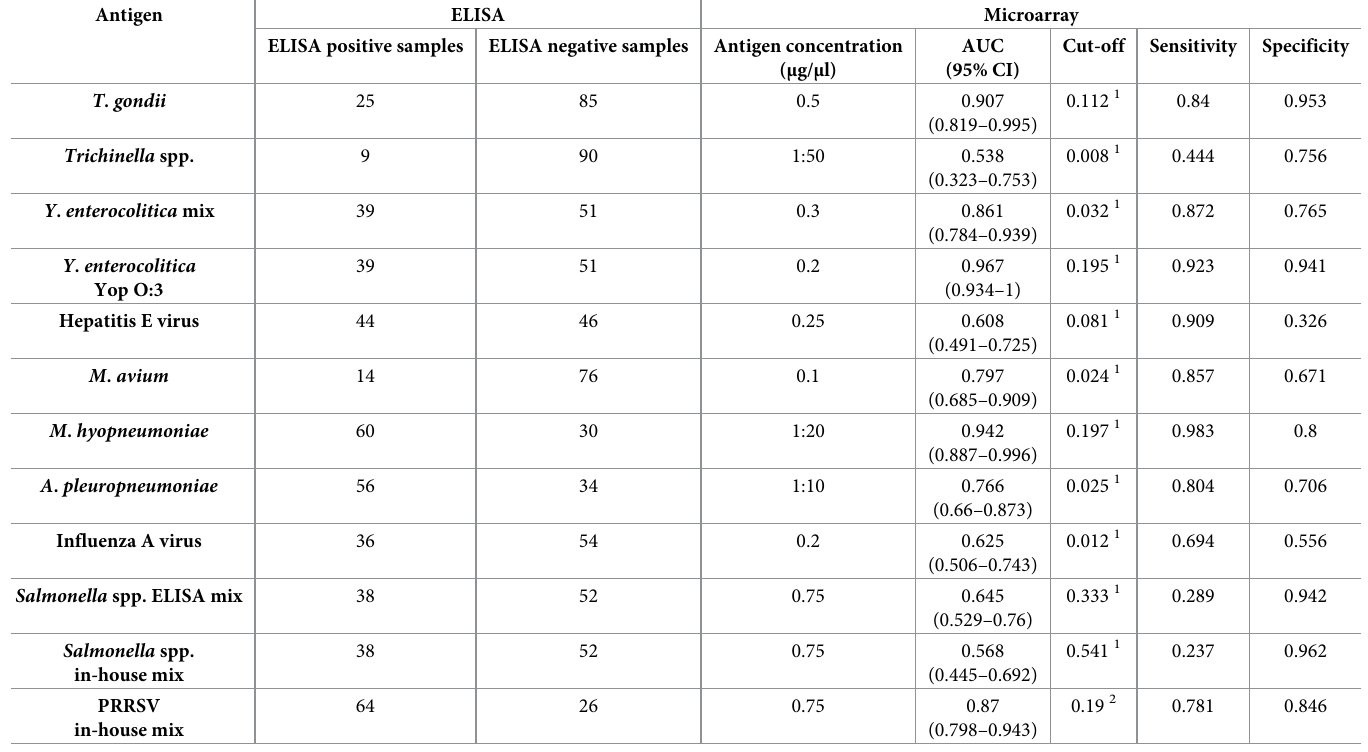
The data of the ROC analysis is shown for the antigen concentration which exceeded the highest area under the curve (AUC). 1 The cut-off value was set to the maximum Youden Index.